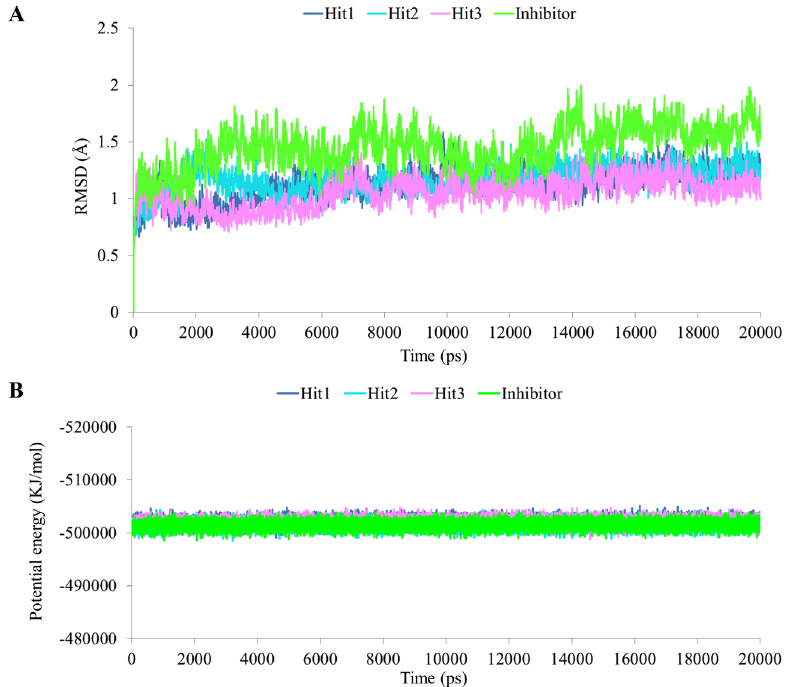
Fig 7. The RMSD and potential energy graph for four complex systems. (A) The RMSD profile for the backbone atoms of Btk protein. (B) The potential energy of the system. These graphs were calculated during 20 ns MD simulations for each complex. Blue, cyan, pink, and green lines represent Hit1, Hit2, Hit3, and Inhibitor